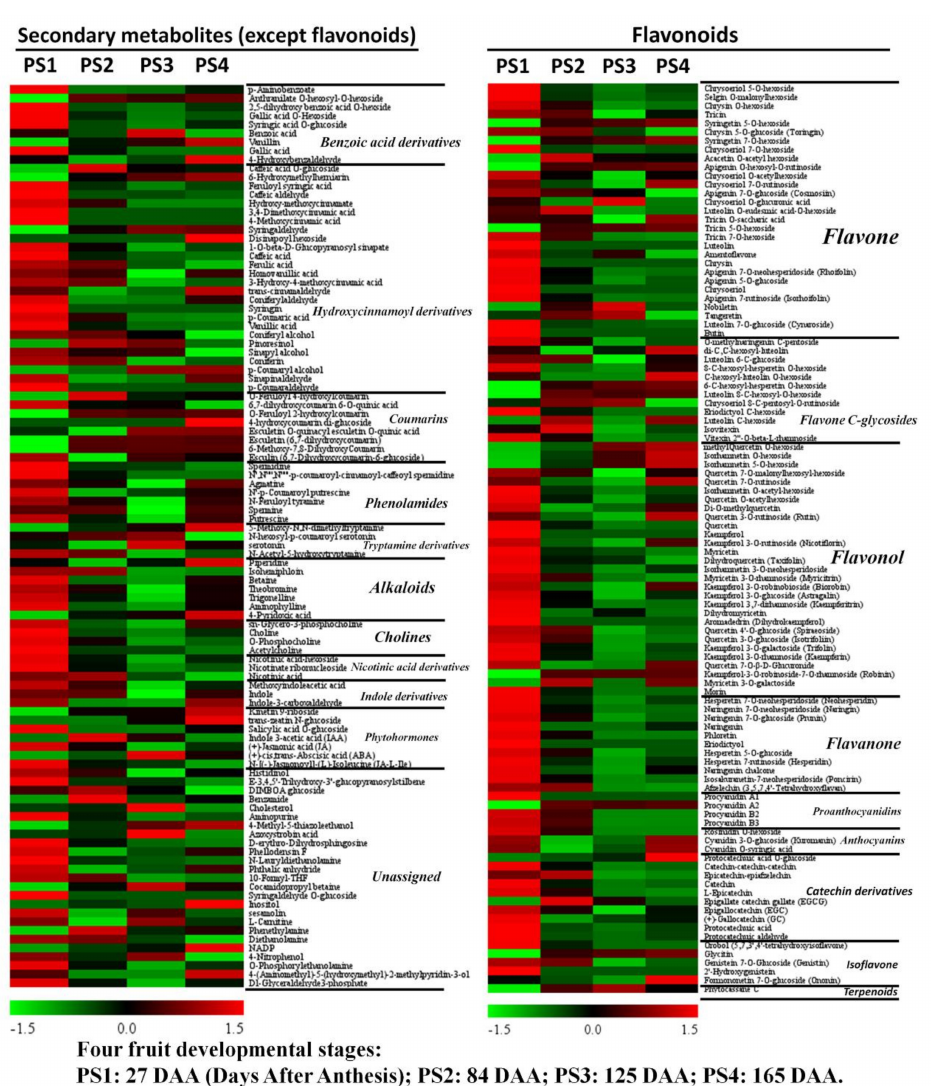
Figure 5. Distributions of accumulation profiles of flavonoids and other secondary metabolites detected by widely targeted UPLC-MC during four fruit-development stages: The colors indicate the proportional content of each identified metabolite as determined by the average peak response area with R scale normalization. PS1, 2, 3 and 4 represent four fruit-development stages: 27, 84, 125 and 165 Days After Anthesis (DAA), respectively. Three independent replicates were performed for each